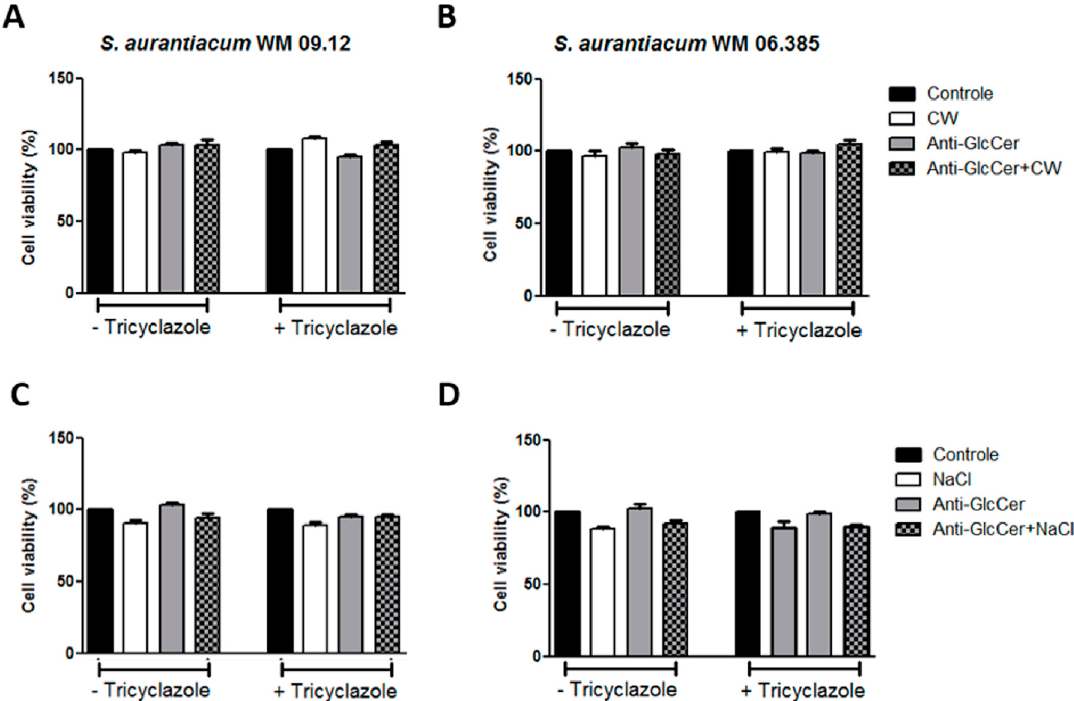
Figure 5. S. aurantiacum WM 09.12 ( A , C ) and WM 06.385 ( B , D ) susceptibility to NaCl and Calcofluor White in the presence of anti-GlcCer (100 µ g / mL). S. aurantiacum cells were pre-incubated with anti-GlcCer for 3 h and then cell viability was determined by XTT-reduction assay after 24 h incubation with Calcofluor White (10 µ g / mL) ( A , B ) or NaCl (3%) ( C , D ). Conidia were cultivated either with ( + ) or without ( − ) tricyclazole (16 µ g / mL). CW, Calcofluor White.